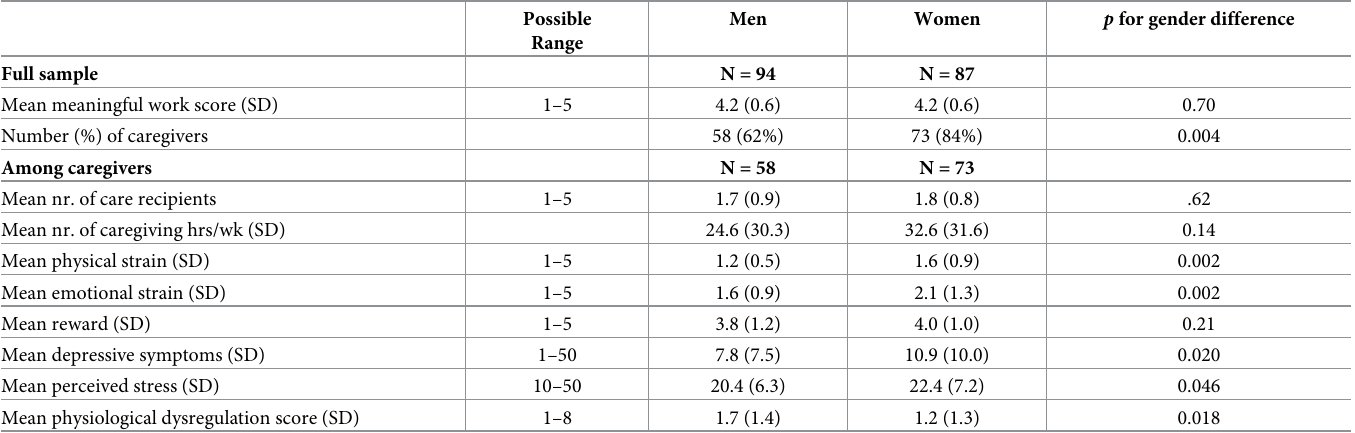
Table 1. Distribution of study variables by gender.